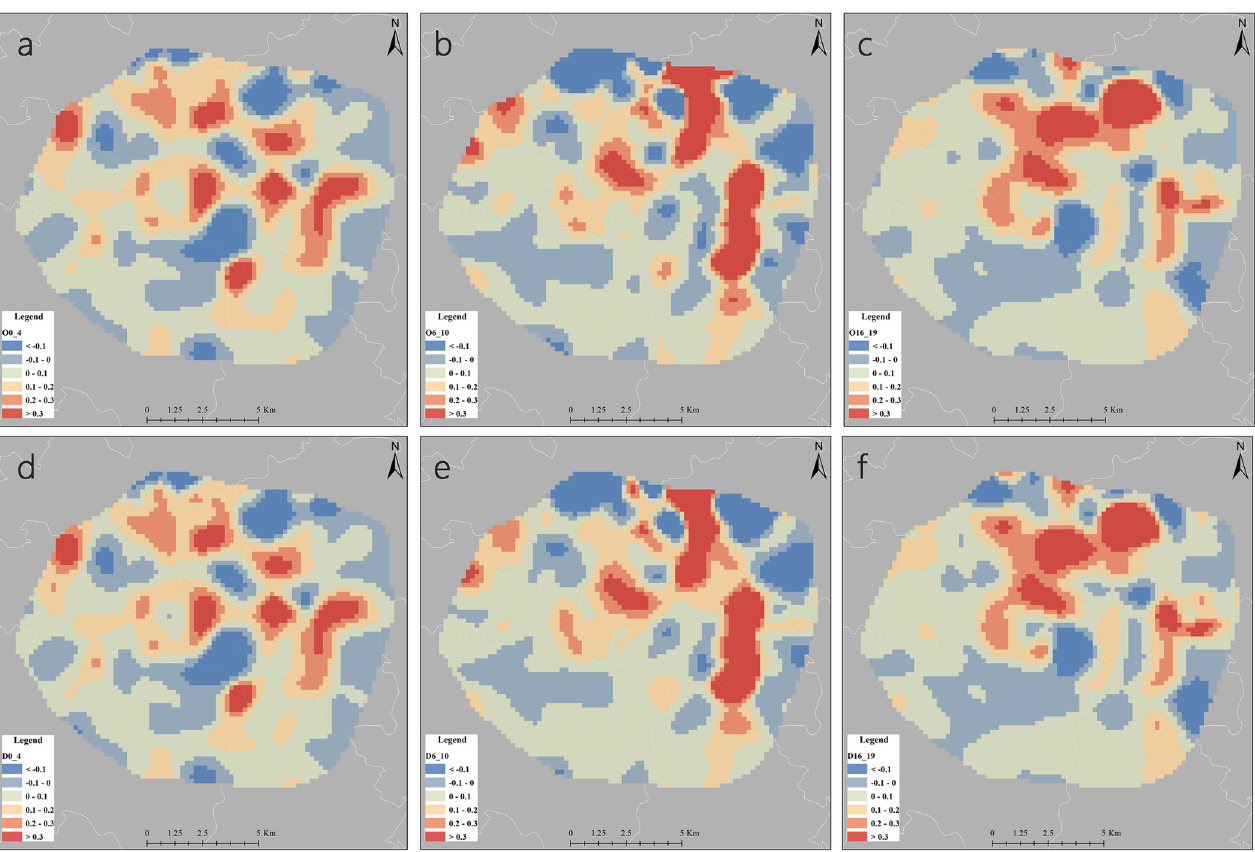
Fig 5. Coefficients of business residence’s spatial-temporal distributions. a/d: Morning peak 1/Morning peak 2 b/e: Evening peak 1/Evening peak 2 c/f: Late night 1/Late night 2. (https://www.openstreetmap.org/copyright).